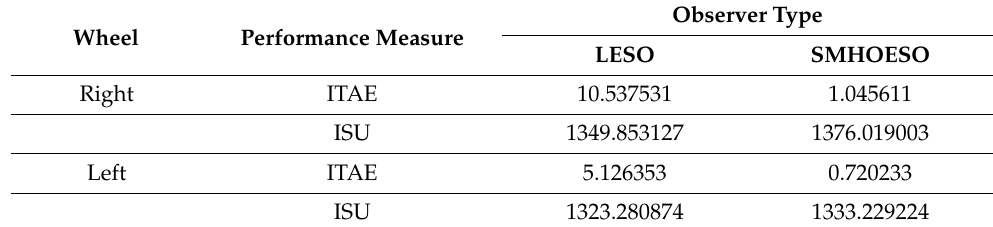
Table 6. Performance measures of both wheels.